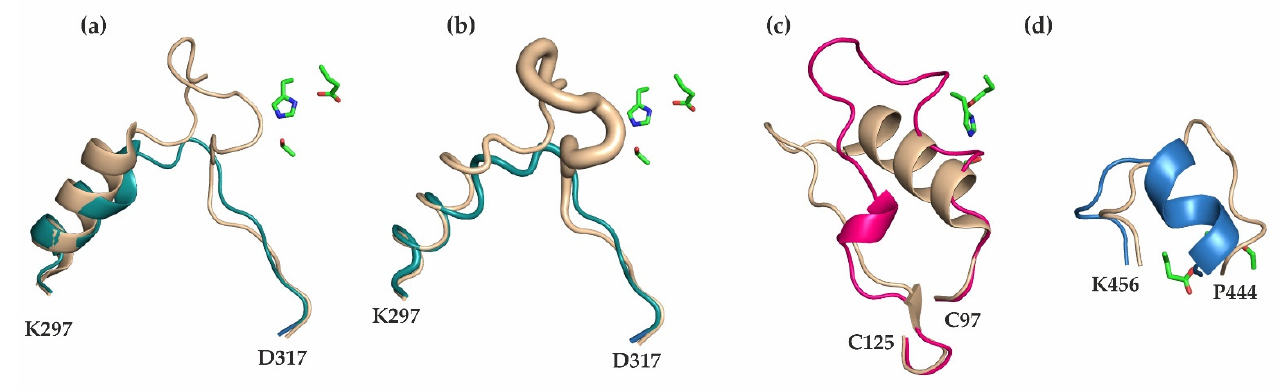
Figure 7. Comparison of mCes2c with hCES1 . ( a ) The cap of hCES1 (wheat) has an extra insertion in a loop compared to mCes2c (teal). ( b ) B-factors in tube representation indicate lower flexibility of the mCes2c cap compared to that of hCES1. ( c ) Differences of mCes2c (lid region in pink) and hCES1 (wheat) in the lid region. ( d ) A loop region from the α / β‐ hydrolase core domain (blue) of mCes2c shows differences to hCES1 (wheat). ( a – d ): The three catalytic triad residues are shown as green sticks.